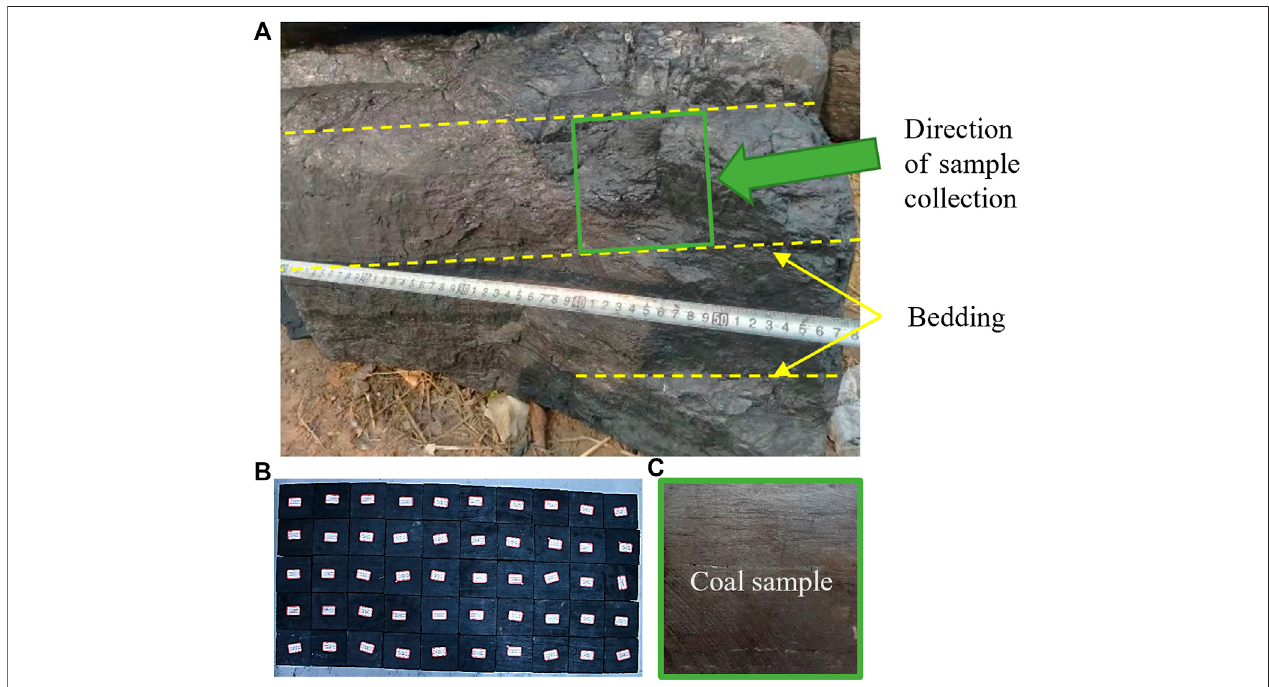
FIGURE 1 | Segments of the coal specimens (A) Field coal block and bedding distribution; (B) Finished product samples; (C) Single coal sample.